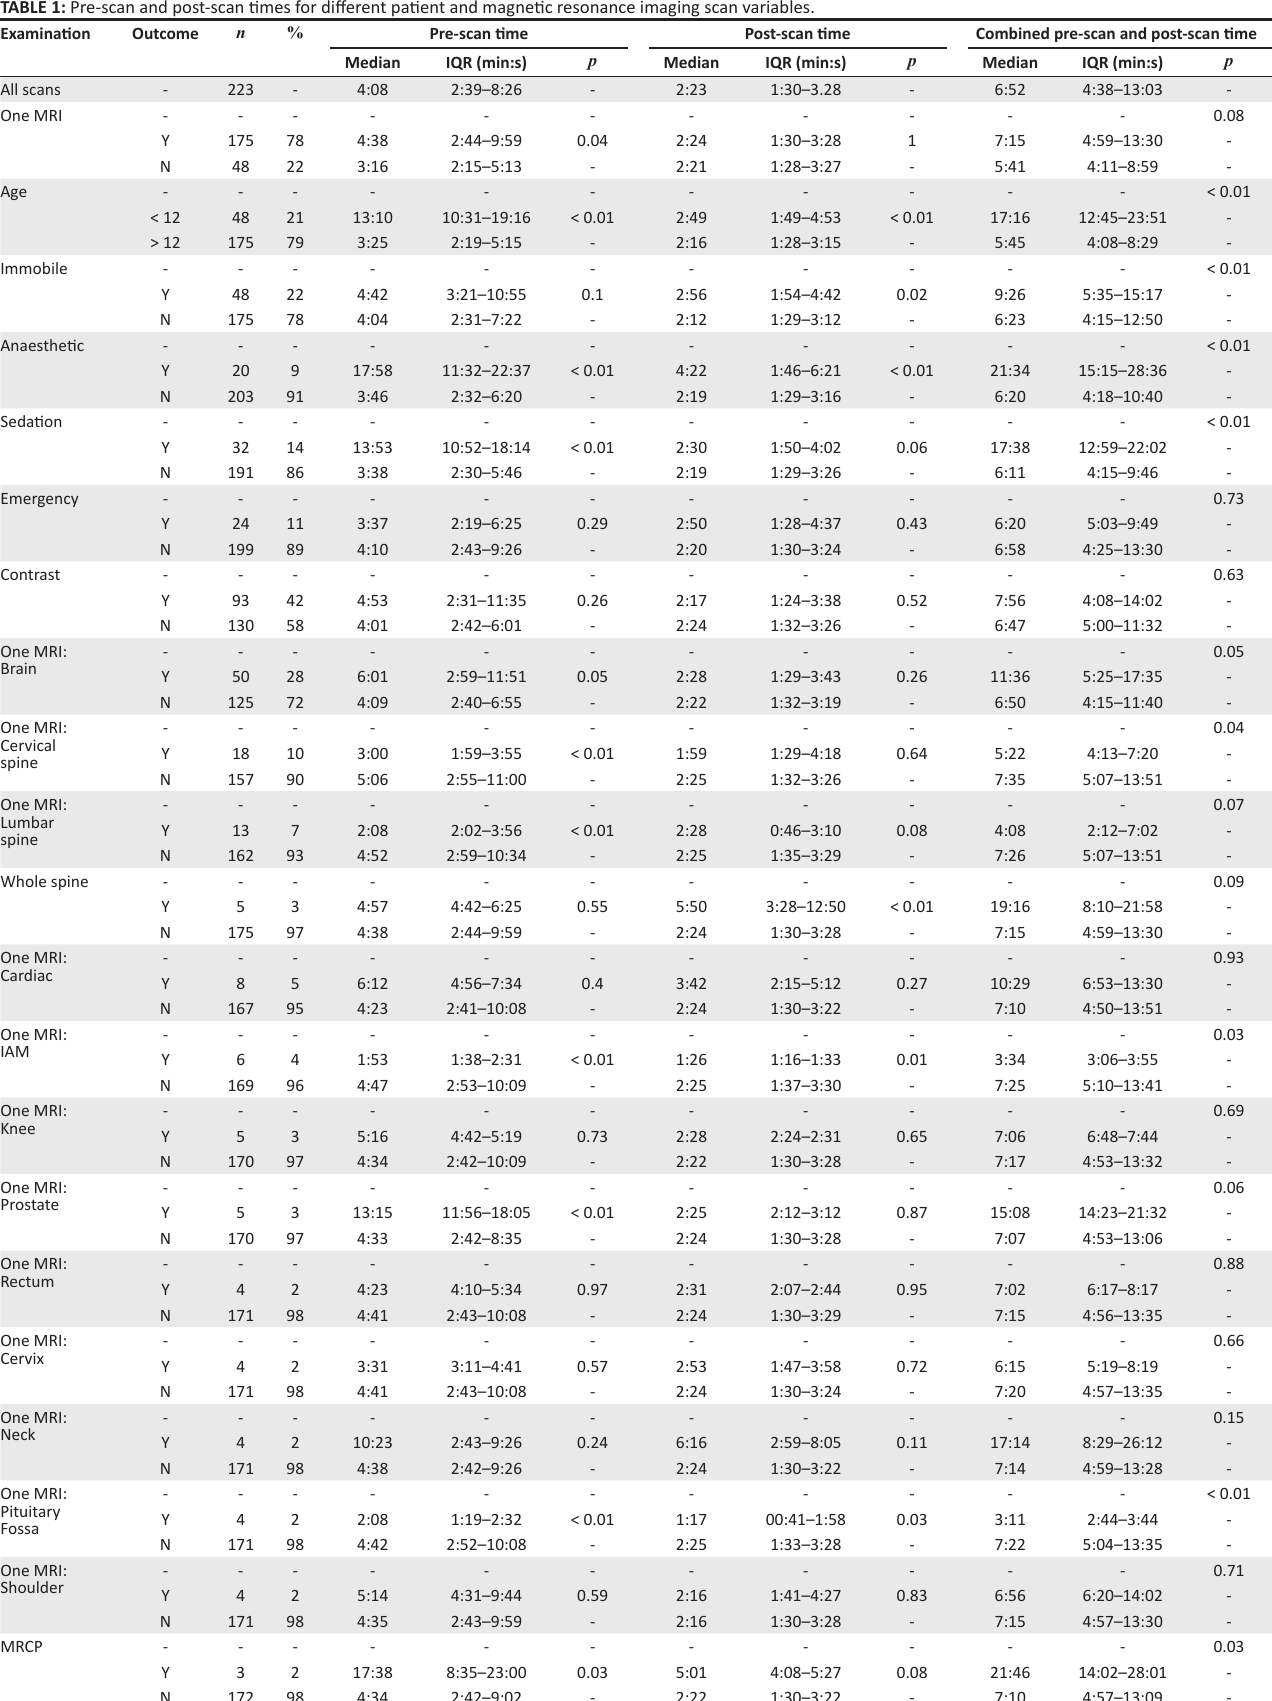
TABLE 1: Pre-scan and post-scan times for different patient and magnetic resonance imaging scan variables. Examination